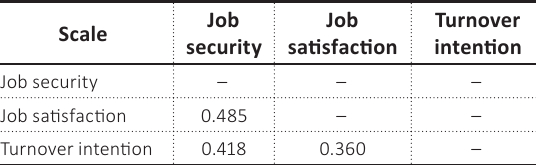
Table 3. Discriminant validity value of HTMT